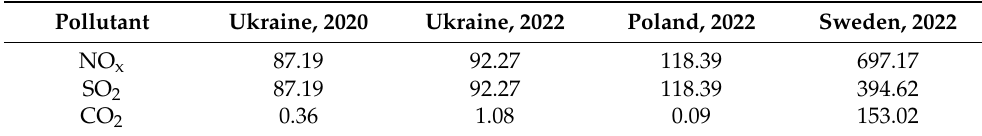
Table 1. Emission tax rates in Ukraine, Poland, and Sweden, USD/t [68,75,76].